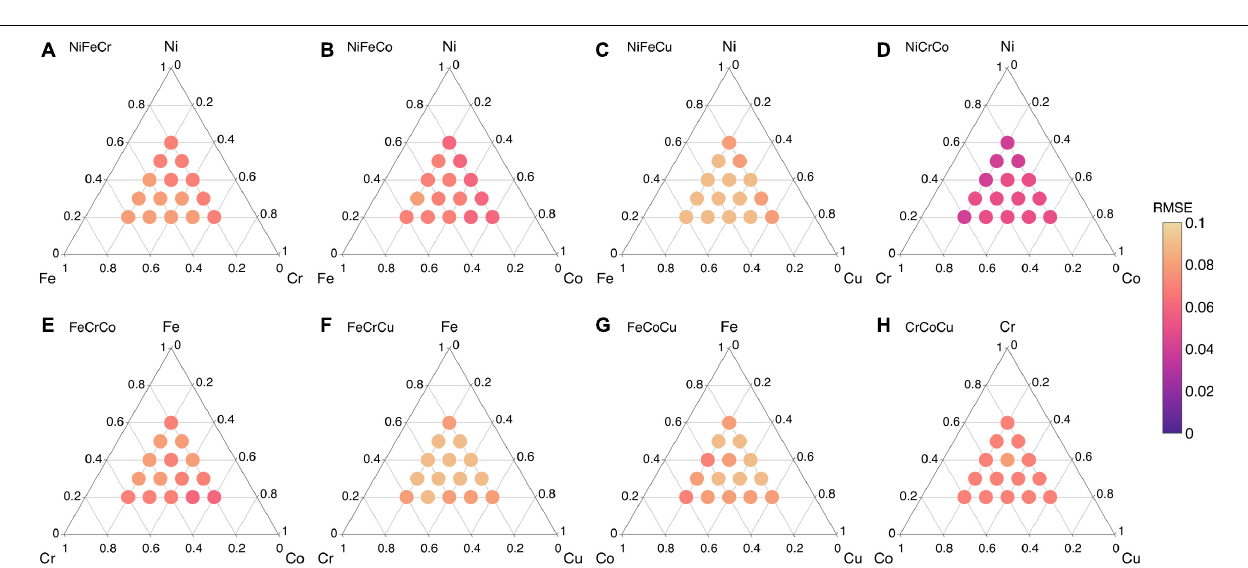
FIGURE 8 | Root mean square error (RMSE) values of ML predicted migration energies of ternary alloys from their constituent binary alloys in (A) NiFeCr, (B) NiFeCo, (C) NiFeCu, (D) NiCrCo, (E) FeCrCo, (F) FeCrCu, (G) FeCoCu, and (H) CrCoCu.